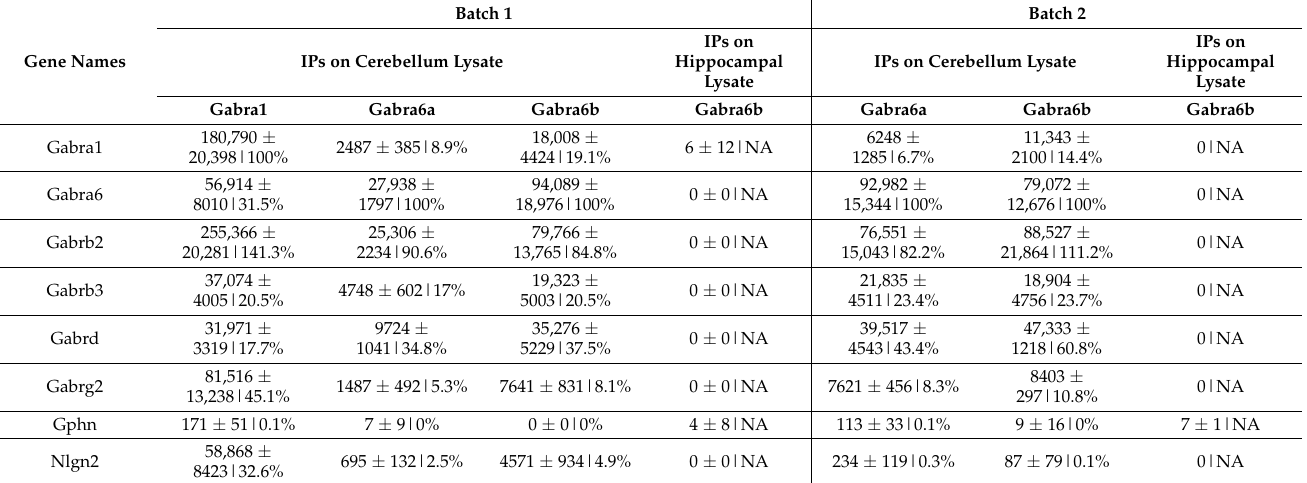
Table 1. Anti-GABA A R α 6 and α 1 subunits IPs. Immunoprecipitation data were presented as ‘average iBAQ value and standard deviation|averaged iBAQ values as % of the bait protein’. NA, not available. ( n = 3 technical replicates per